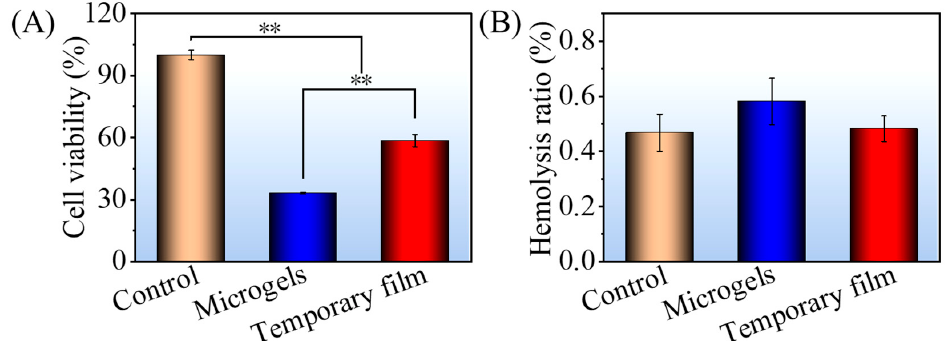
Figure 6. Cytotoxicity of NIH3T3 cells ( A ) and hemolysis rate ( B ) of PCD film (control), microgels, and temporary film. Significance was defined as ** p < 0.01, n =